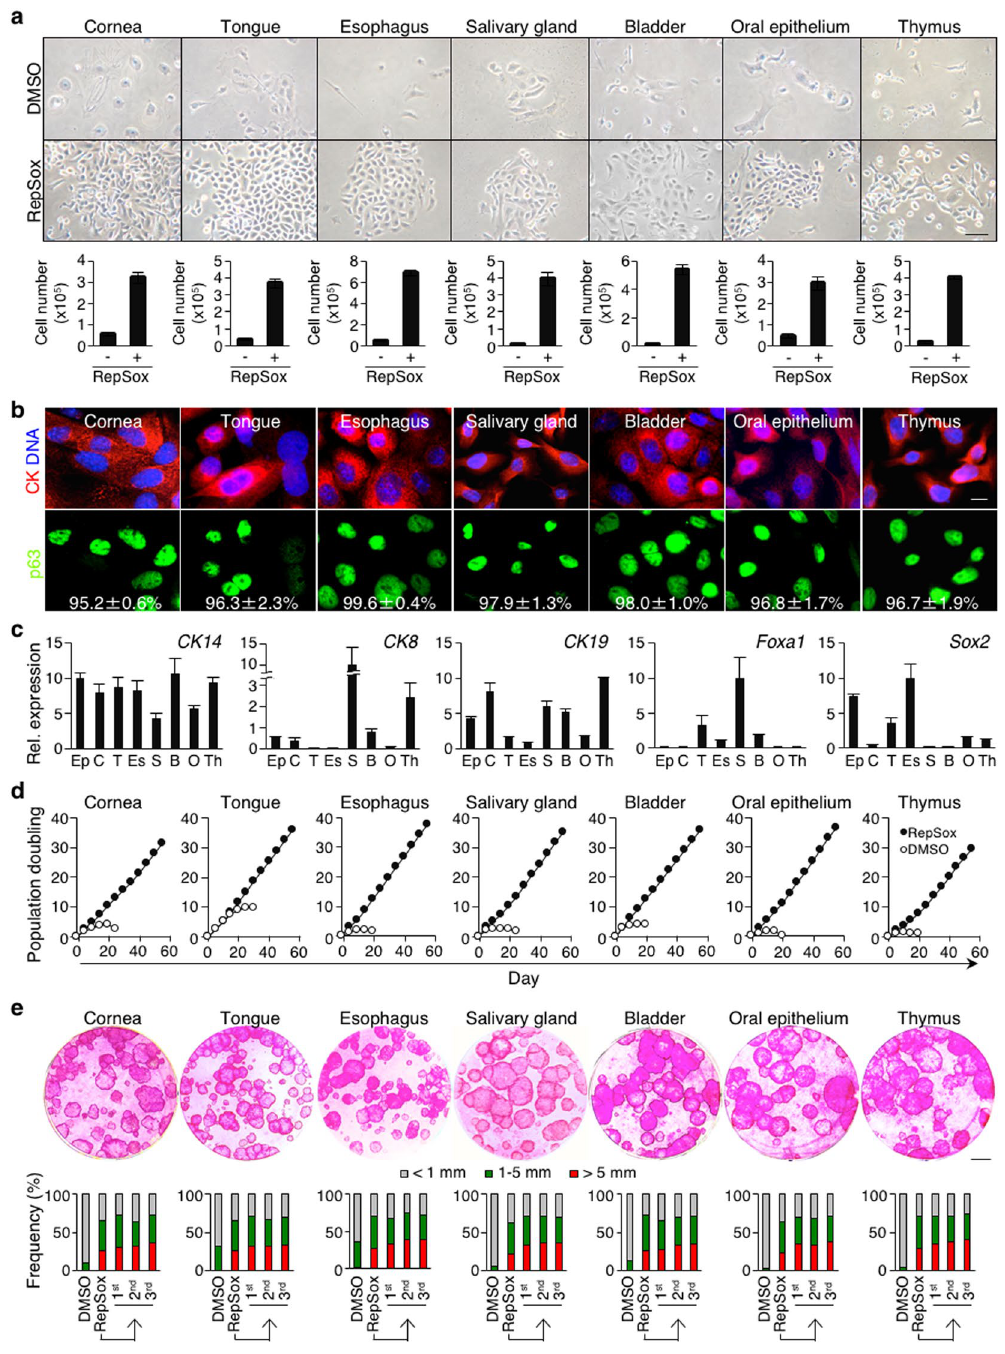
Figure 5. Inhibition of TGF- β signaling enables long-term expansion of p63 + epithelial progenitor cells of diverse mouse epithelia. ( a ) Representative images of primary cells of various newborn mouse epithelia, grown in the presence (lower) or absence (upper) of 1 μ M RepSox for 6 days. Bar = 50 μ m. Bar graphs below indicate numbers of primary cells at day 7 of culture. CnT-PR-expanded CK + mouse primary epithelial cells (2 × 10 4 ) were seeded. Data shown are mean ± s.e.m. (n = 3). ( b ) Representative immunofluorescence images of newborn mouse-derived, RepSox-expanded P2 epithelial cells stained with anti-p63 and anti-pan-CK antibodies and counterstained with Hoechst 33342 (DNA). Numbers shown in lower panels represent percentages of p63 + cells per field, expressed as mean ± s.e.m. (n ≥ 4). Bar = 10 μ m. ( c ) Quantitative RT-PCR analysis of epithelial progenitor cell-associated genes using newborn mouse-derived, RepSox-expanded P9 (thymus and salivary gland), P10 (epidermis), and P11 (cornea, oral epithelium, tongue, esophagus and bladder) cells. For each gene, the highest expression was set to 10. Data shown are normalized to the housekeeping gene Rps18 and expressed as mean ± s.e.m. (n = 3). Ep , epidermis; C , cornea; T , tongue; Es , esophagus; S , salivary gland; B , bladder; O , oral epithelium; and Th , thymus. ( d ) Population doubling of newborn mouse-derived, RepSox-expanded P2 epithelial cells grown in CnT-PR media in the presence (solid) or absence (open) of 1 μ M RepSox. ( e ) 3T3-J2